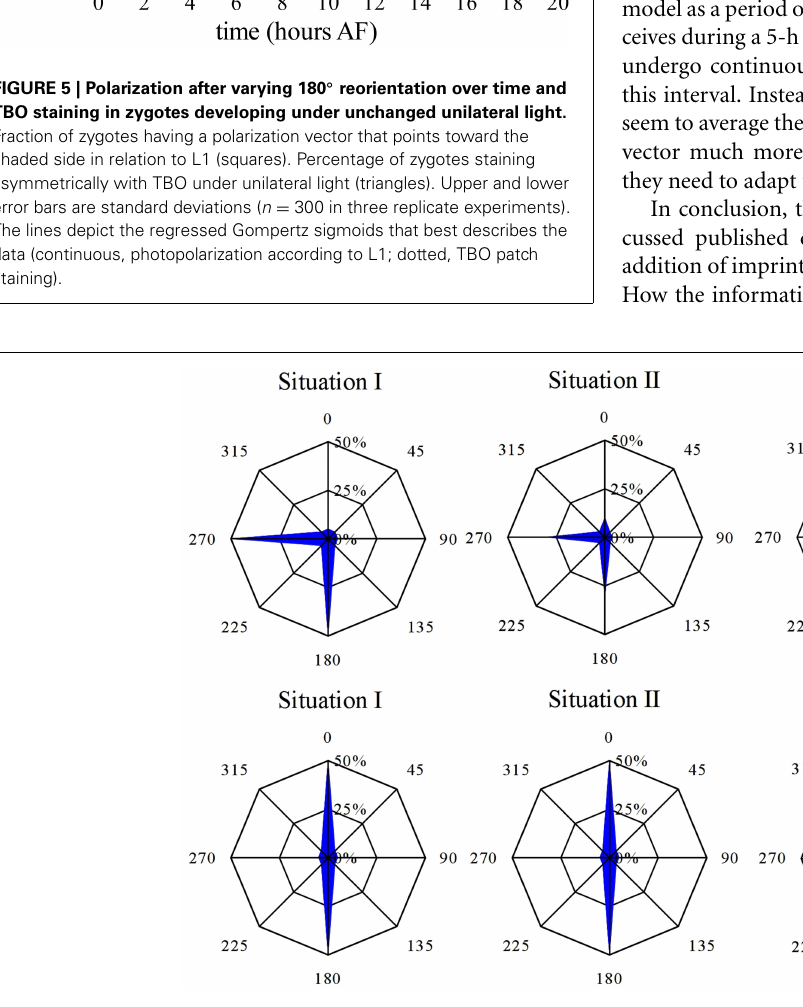
Frontiers in Plant Science | Plant Evolution and